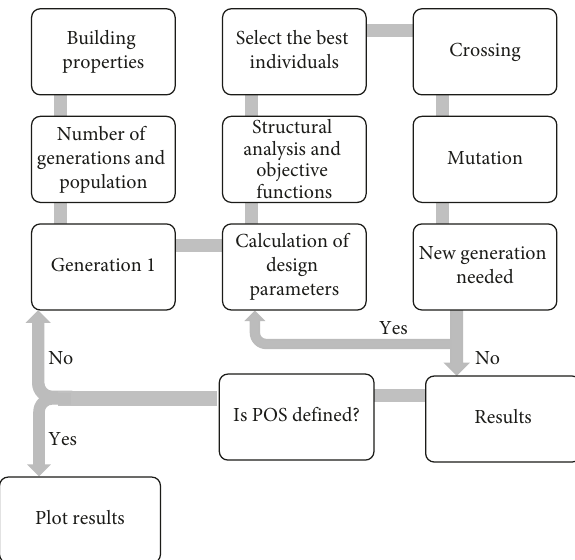
Figure 3: Flowchart used for the design of three-dimensional RC buildings.